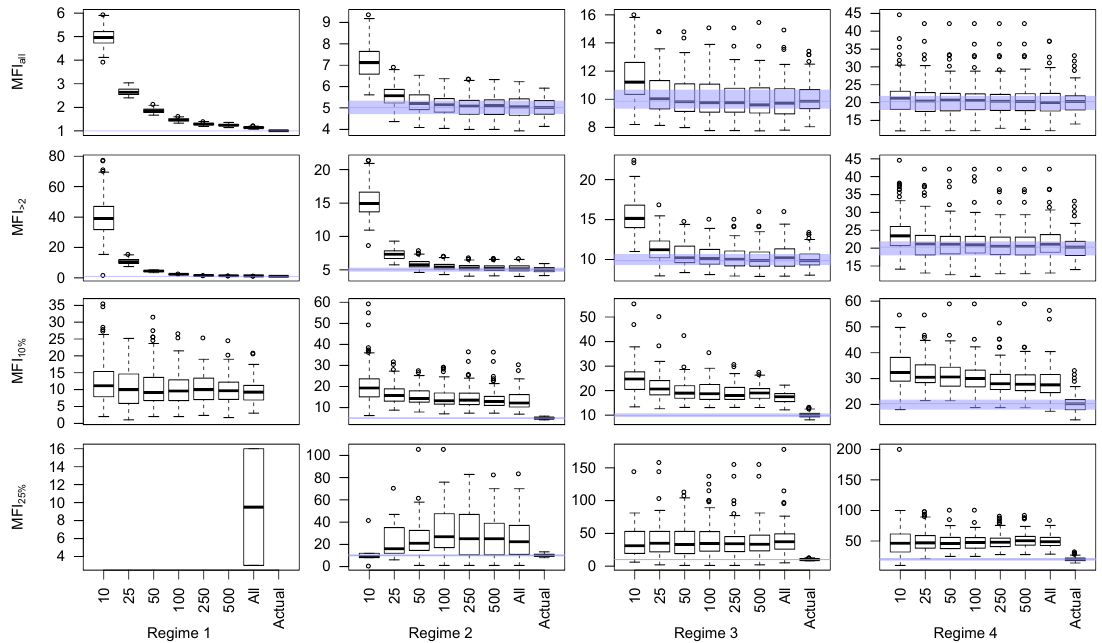
Figure 1. Box and whisker plots of tree-ring reconstructed mean fire interval (MFI) measurements (y-axes) by fire regime (columns), filter level (rows), and by sample size (x-axes) for targeted sampling strategies. The shaded region is the range of actual fire-intervals experienced across all 100 simulations for that fire regime. Note that MFI all accurately describes all fire regime at 50 or fewer samples. Note also that when filtering the fire-scar record at 10% or 25% level, targeted sampling regimes never accurately describe any of the fire regimes.